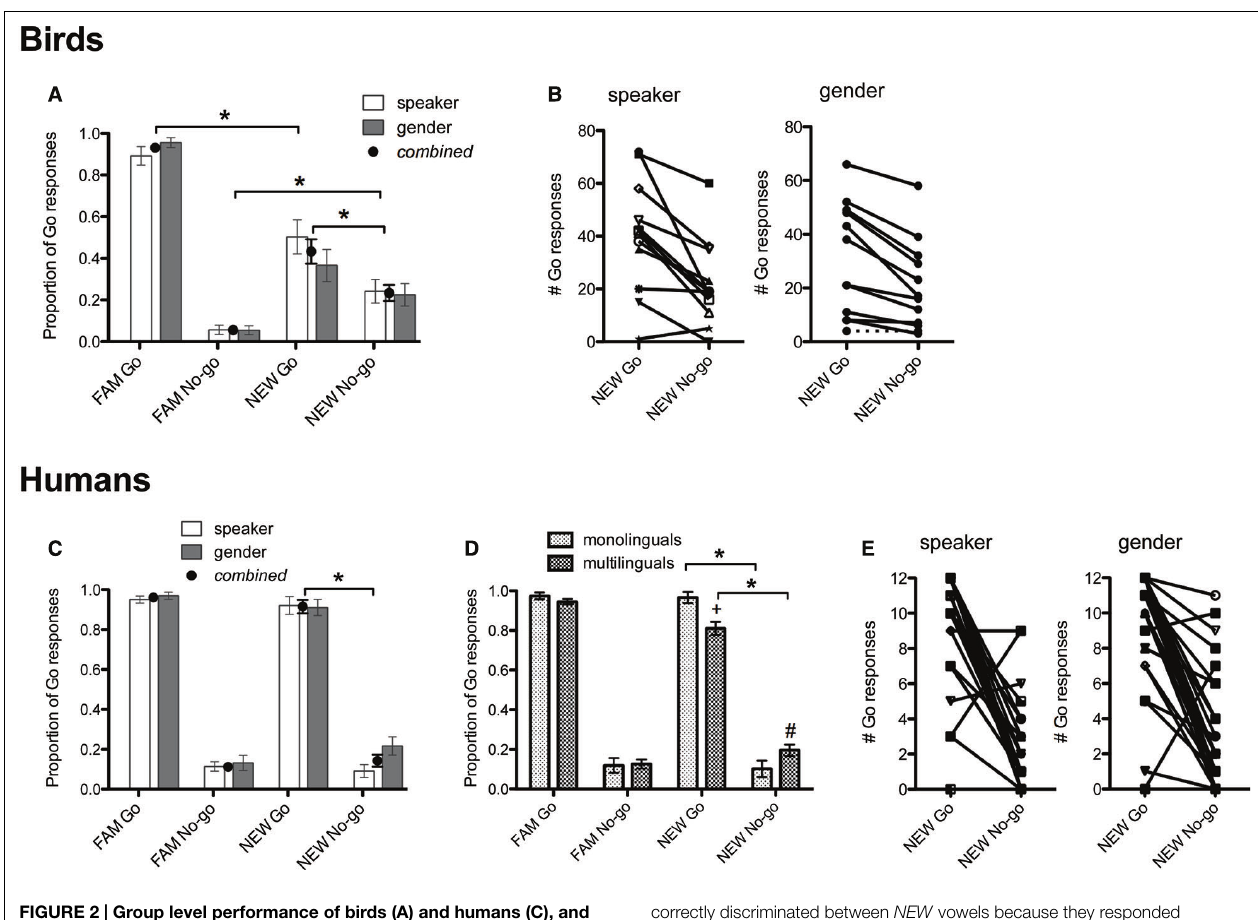
FIGURE 2 | Group level performance of birds (A) and humans (C), and individual level performance of birds (B) and humans (E) in Experiment 1. Dotted line in (B) shows performance of bird 257 (discussed in Experiment 2 Results). In (A,C) , black dots represent the combined average of performance on speaker and gender normalization conditions (which were not significantly different from each other). Birds and humans